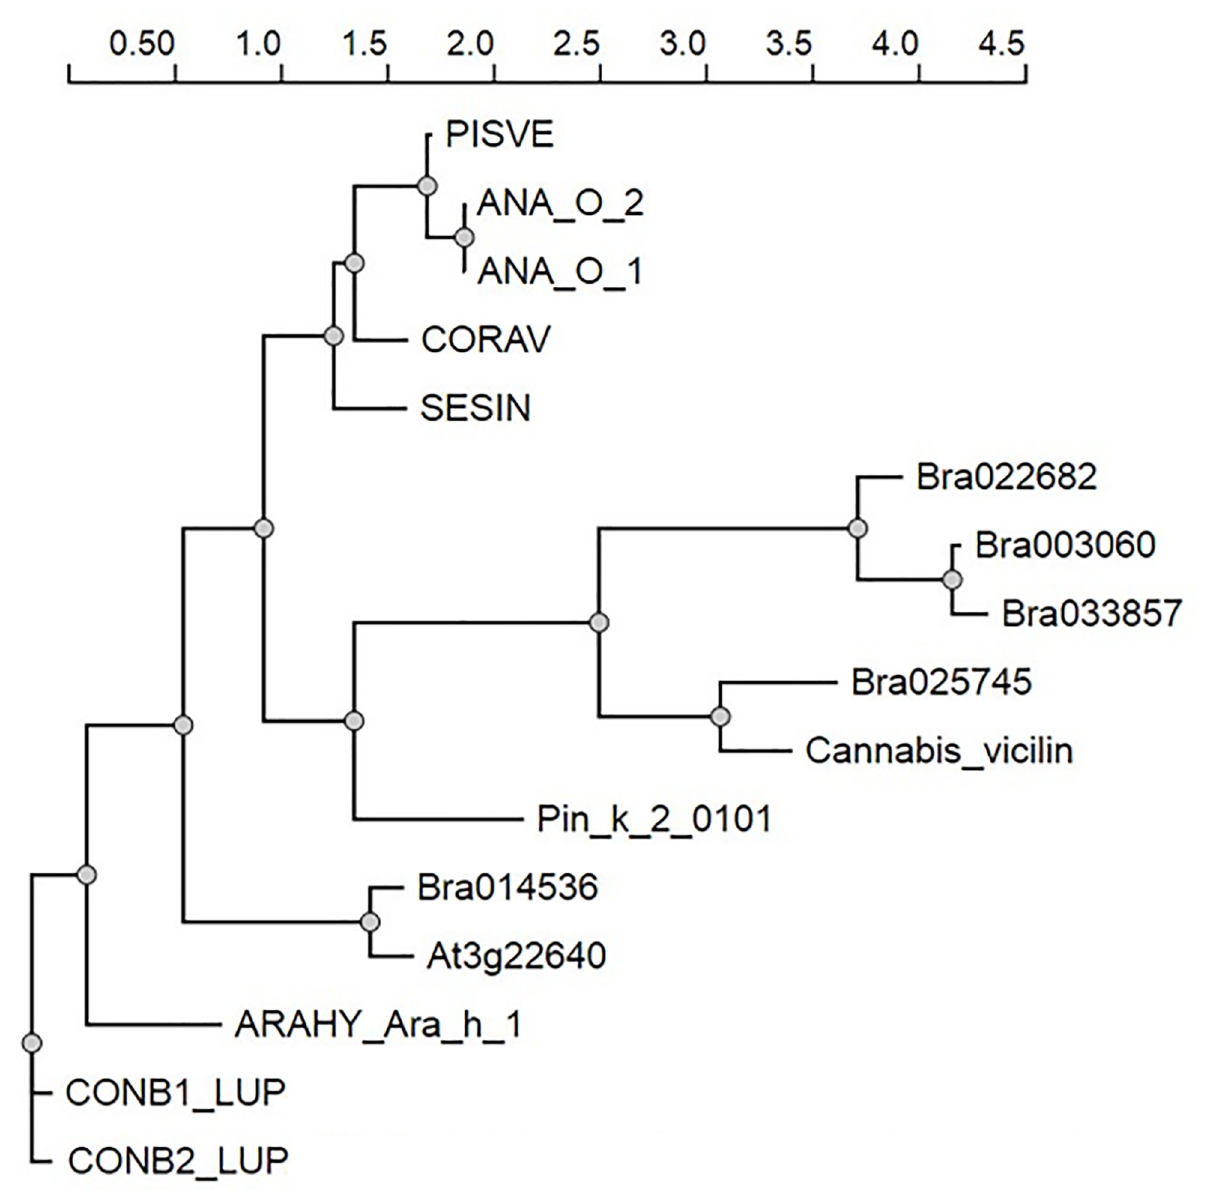
Fig 8. Phylogenetic tree of vicilin-like proteins. The phylogenetic tree was constructed using the maximum likelihood method in NGPhylogeny.fr web resource (https://ngphylogeny.fr/workflows/oneclick/, 30/05/2020). The tree was constructed using the five 7S globulin-like vicilin protein sequences identified in Brassica rapa R-o-18, as well as 7S globulin like vicilin protein sequences reported in different plant species including Arabidopsis thaliana (At3g22640), Cannabis sativa (Cannabis_vicilin), cashew ( Anacardium occidental ) (ANA_O-1 and ANA_O_2), narrow-leaved blue lupine ( Lupinus angustifolius ) (CONB1_LUP), w hite lupine ( Lupinus albus ) (CONB2_LUP), sesame ( Sesamum indicum ) (SESIN), Korean pine (Pinus koraiensis) (Pin_k_2_0101) , pistachio ( Pistacia vera ) (PISVE), European hazel ( Corylus avellana ) (CORAV) and peanut ( Arachis hypogaea ) (ARAHY_Ara_h_1), all available in public domain databases. The full-length sequences of identified vicilins are presented in S5 Table in S1 File, while the other sequences are presented in S1 Table in S1 File. The scale above the tree represents the in-built distance matrix employed in NGPhylogeny.fr web resource and indicates the distance based on the sequence similarity of their features.